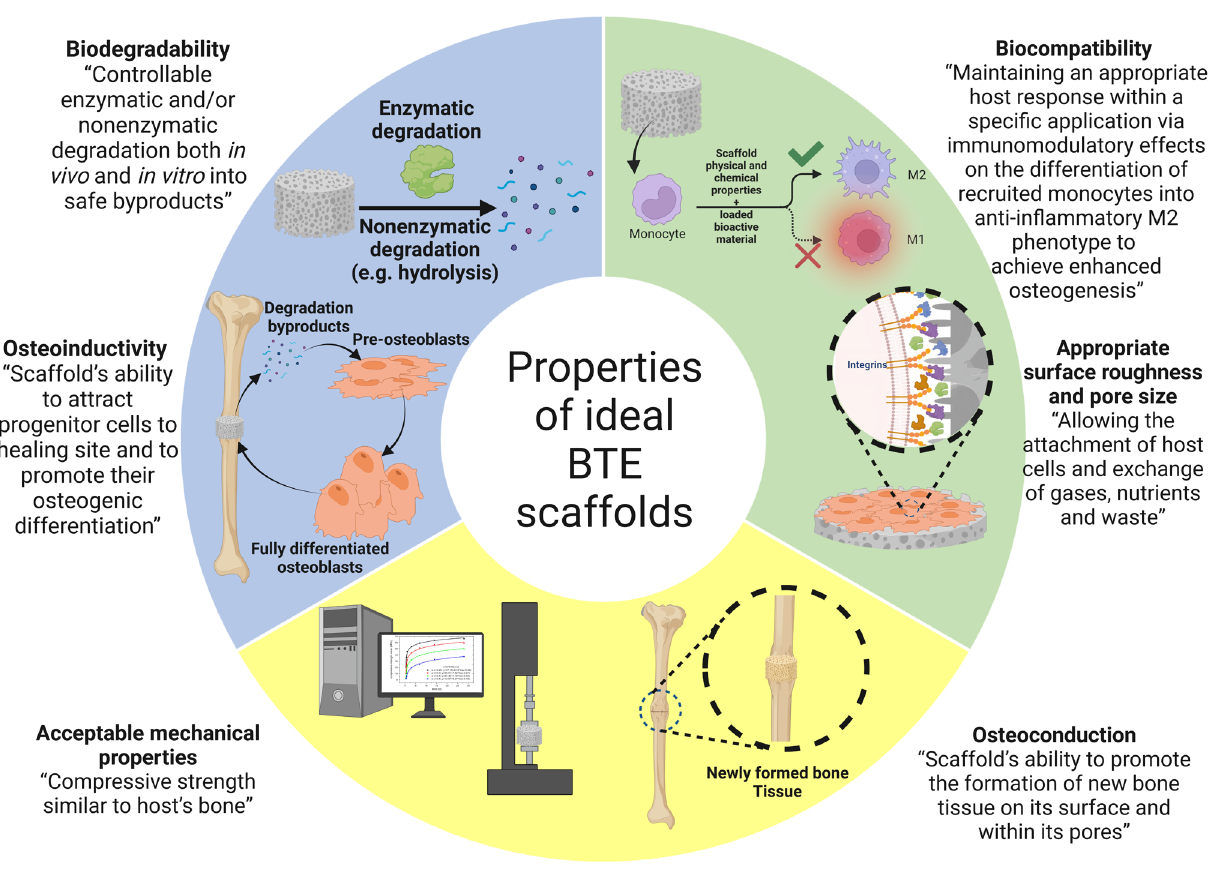
Figure 4. The properties of ideal bone tissue engineering scaffold. The image was created using Biorender.